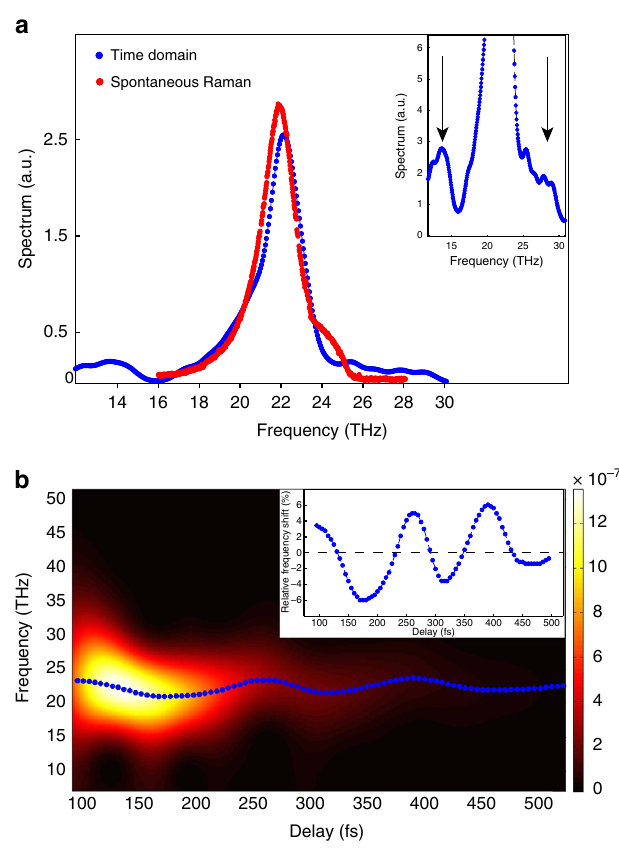
Figure 5 | Spectrum of the ultrafast response of the antiferromagnetic vector. ( a ) The Fourier transform of the time trace measured at 80K (blue curve) is compared with the spontaneous Raman spectrum obtained at the same temperature (red curve). In the inset a zoom of the Fourier transform reveals two sidebands at E ± 7.5THz away from the peak frequency. ( b ) The squared modulus of the Wigner distribution of the signal is represented by the colour plot. At each time step a blue dotted line highlights the maximum of the spectrum, in which black represents zero intensity. In the inset the relative frequency shift (equation (4)) is plotted as a function of the delay showing E 7.5THz corresponds to the longitudinal dynamics of the order parameter (equations (11) and (12) and Supplementary Note 2).